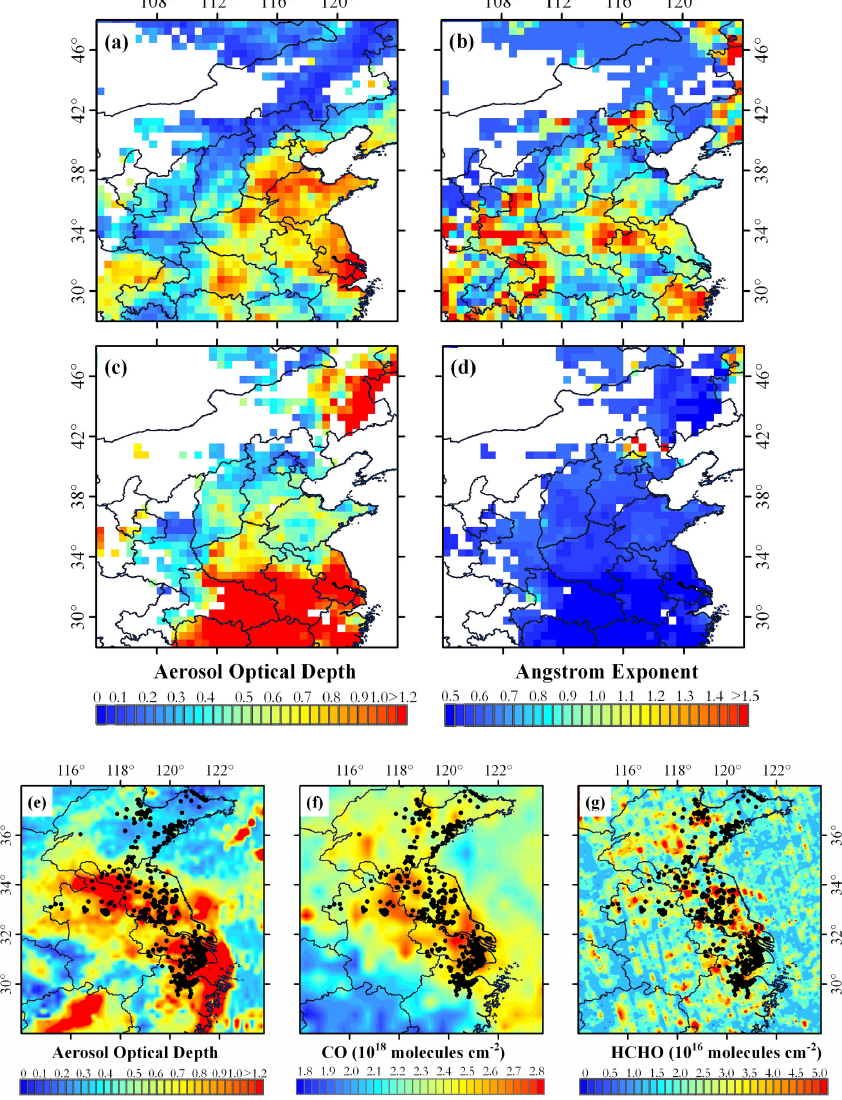
Fig. 5. The regional distribution of (a) aerosol optical depth (550 nm), and (b) Ångström exponent (470 – 670 nm) retrieved from MODIS during PE1; (c) aerosol optical depth, and (d) Ångström exponent during PE2; (e) aerosol optical depth, (f) total CO column concentration (molecules cm -2 ) retrieved from AIRS, and (g) total formaldehyde column concentration (molecules cm -2 ) retrieved from OMI during PE3, respectively. Total fire spots (black dots in the figure) retrieved from MODIS were plotted for PE3.